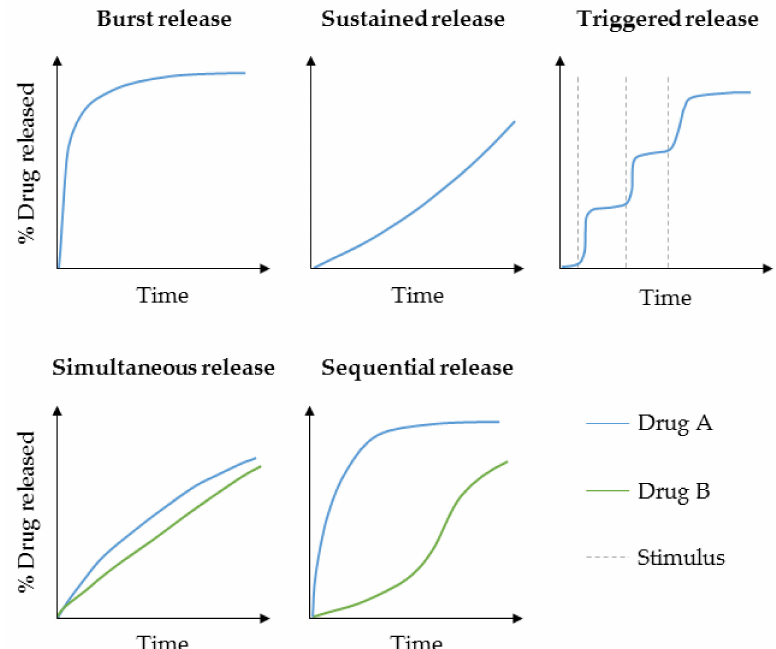
Figure 1. Exemplary schematic drug release kinetics for single and dual drug